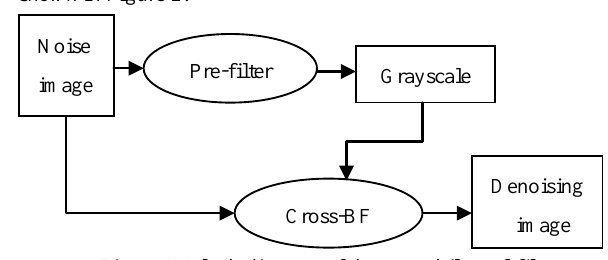
Figure 2. Block diagram of the cross-bilateral